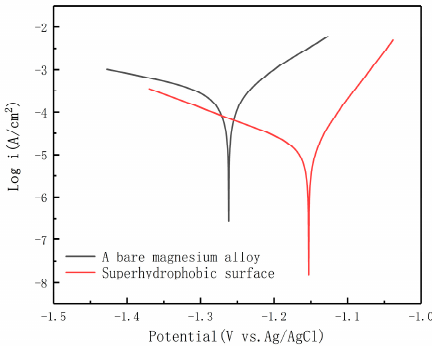
Figure 8. Potentiodynamic polarization curves of the AZ91D Mg substrate and the superhydrophobic surface in the 3.5 wt. % NaCl solution.